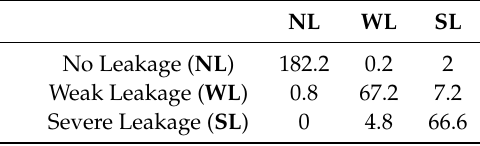
Table 9. Confusion matrix of ther Internal Pump Leakage